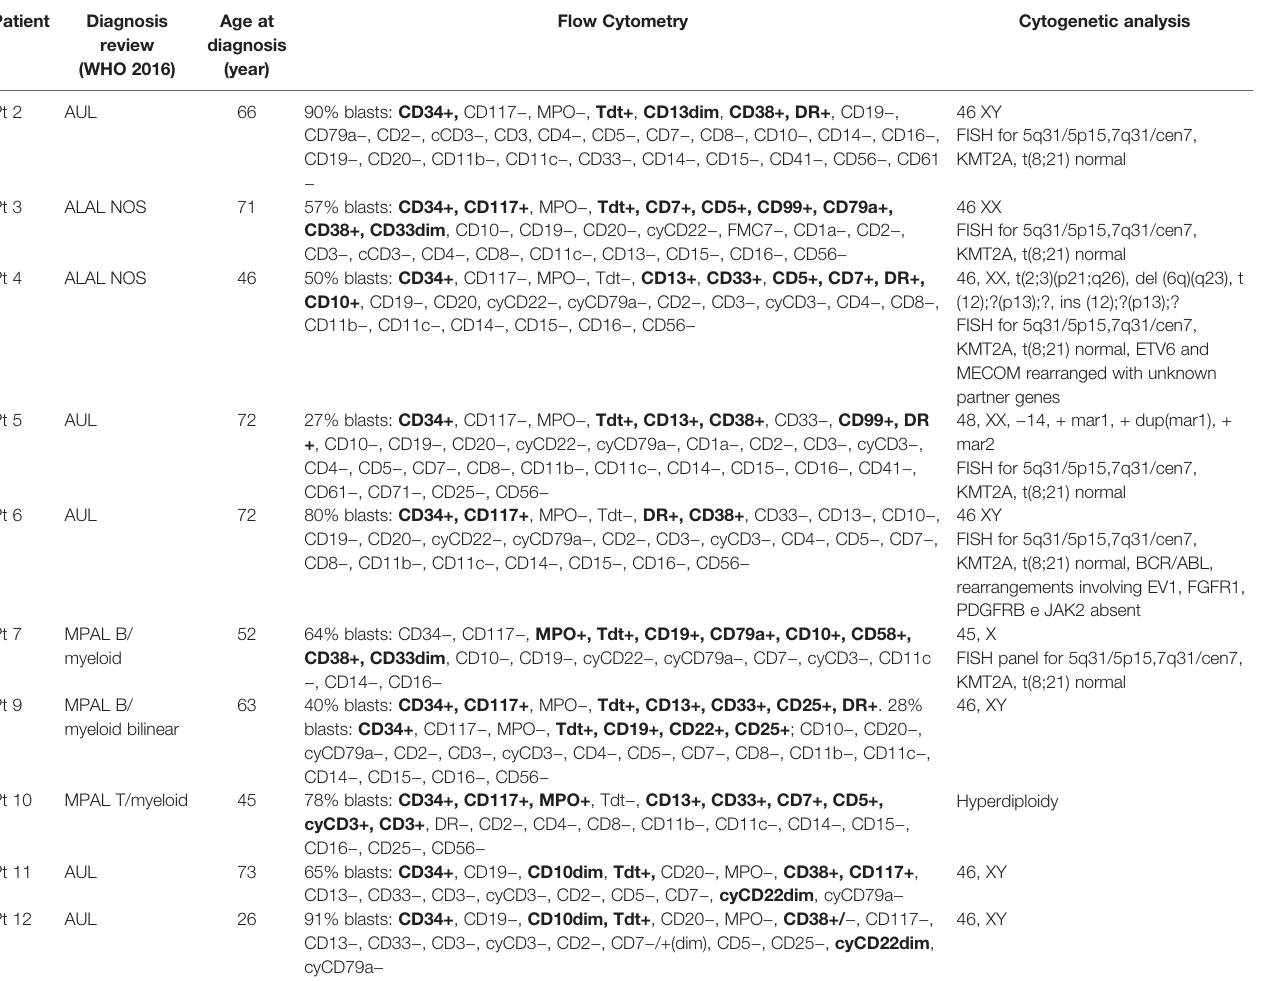
Bold values highlight positive fl ow cytometry